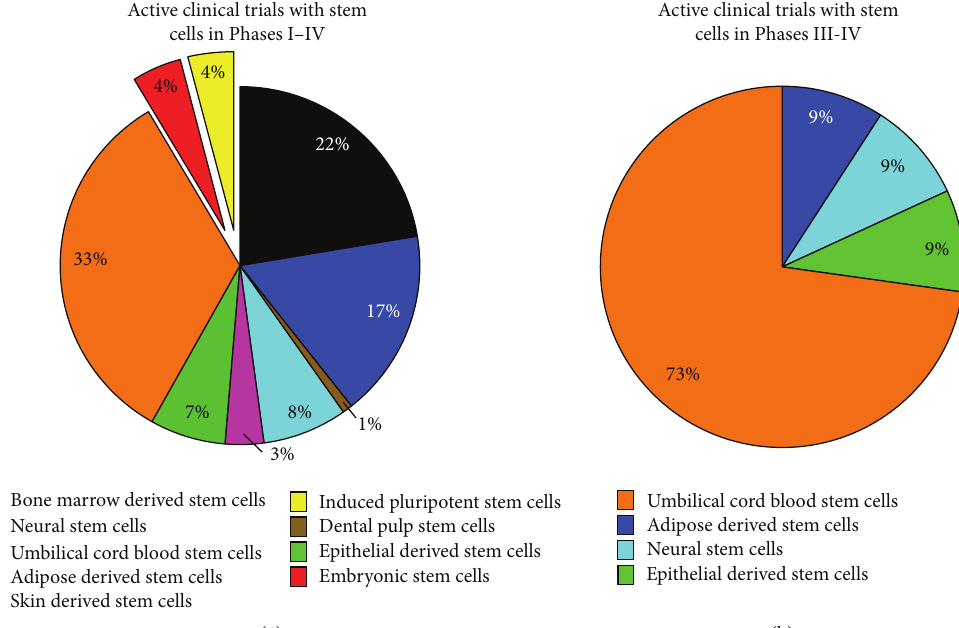
Figure 1: Summary of active (nonrecruiting) clinical trials using stem cell sources internationally. The search was performed on the website of ClinicalTrials.gov (https://clinicaltrials.gov/) on July 28, 2015, and results show there are 117 active studies (a) with 11 studies currently in Phase III or Phase IV clinical trials. Keywords included “Bone marrow derived stem cells” ( 𝑛 = 26 ), “Adipose derived stem cells” ( 𝑛 = 20 ), “Dental pulp stem cells” ( 𝑛 = 1 ), “Neural stem cells” ( 𝑛 = 9 ), “Skin derived stem cells” ( 𝑛 = 4 ), “Epithelial derived stem cells” ( 𝑛 = 8 ), “Umbilical cord blood stem cells” ( 𝑛 = 39 ), “Embryonic stem cells” ( 𝑛 = 5 ), and “Induced pluripotent stem cells” ( 𝑛 = 5 ). With regard to the Phase III and Phase IV trials (b) umbilical cord blood stem cells are the most common stem cells sources ( 𝑛 = 8 ) followed by adipose derived stem cells ( 𝑛 = 1 ), neural stem cells ( 𝑛 = 1 ), and epithelial stem cells ( 𝑛 = 1